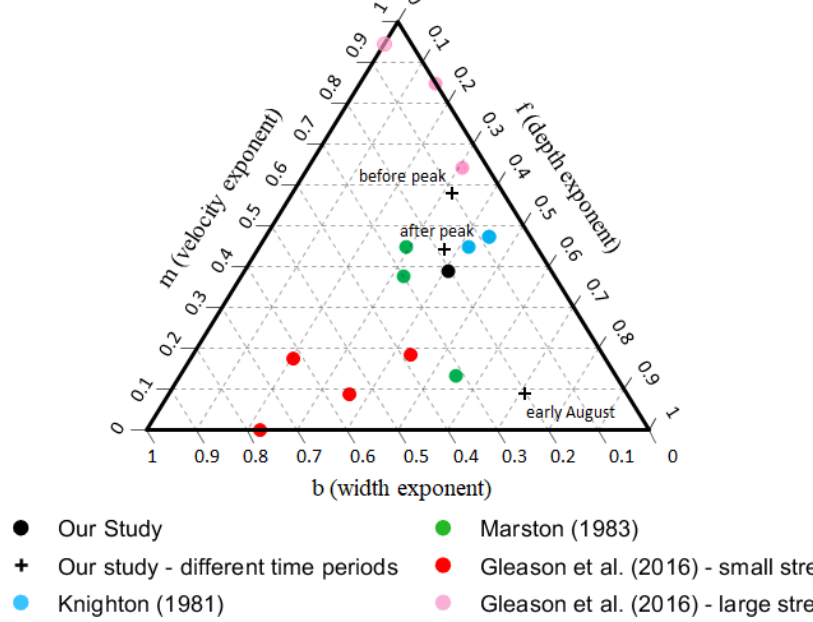
Figure 11. Ternary diagram comparing m , f , and b parameters from this study (in black; whole season shown by solid dot; different time periods shown by “ + ” with before peak being 17 June–20 July, after peak being 26–27 July, and early August being 4 August) with previous work by Knighton (1981) in blue, Marston (1983) in green, and Gleason et al. (2016) large streams in pink and small streams in red. Where m + f + b exceeded unity, parameters were adjusted to